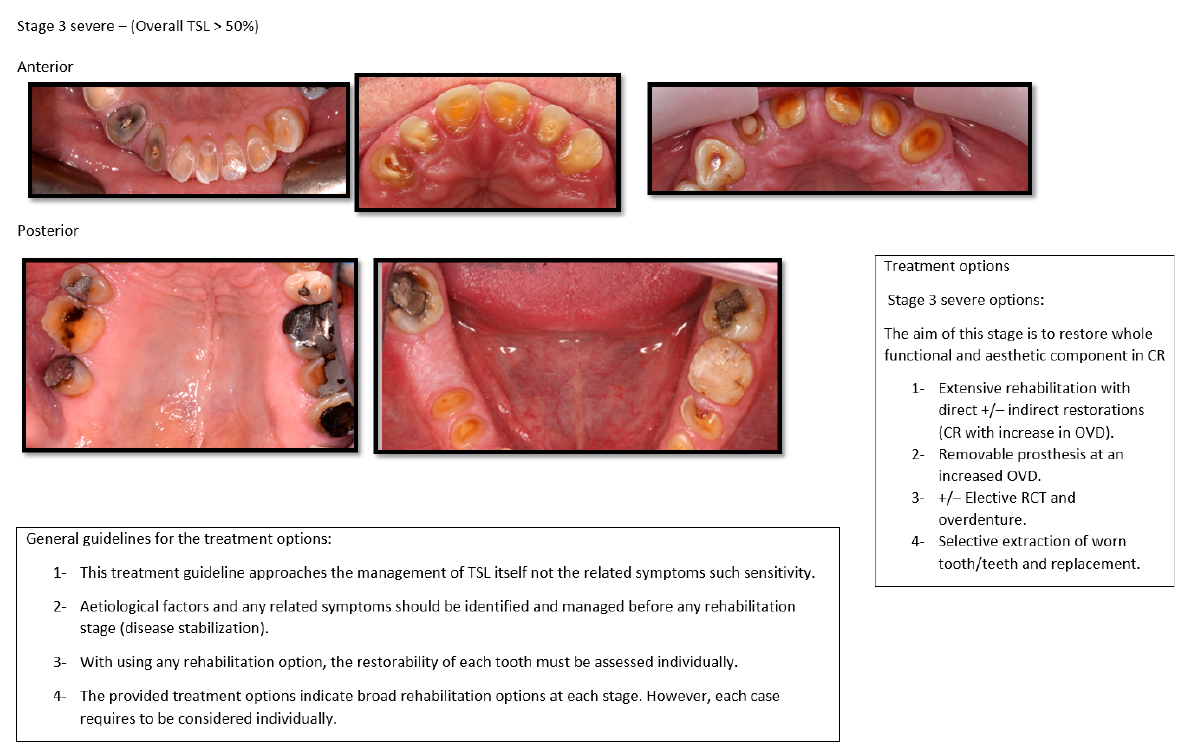
Figure 4. Photographic version of the classification tools with suggested treatment for Stage 2.